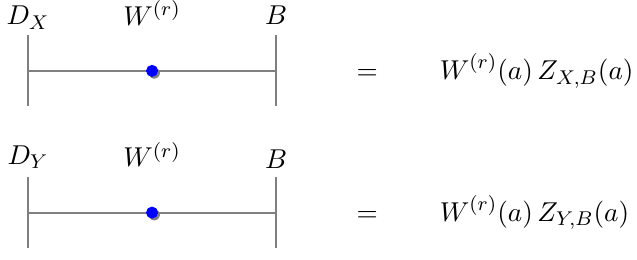
Figure 9 . Correlation functions with supersymmetric Wilson loops